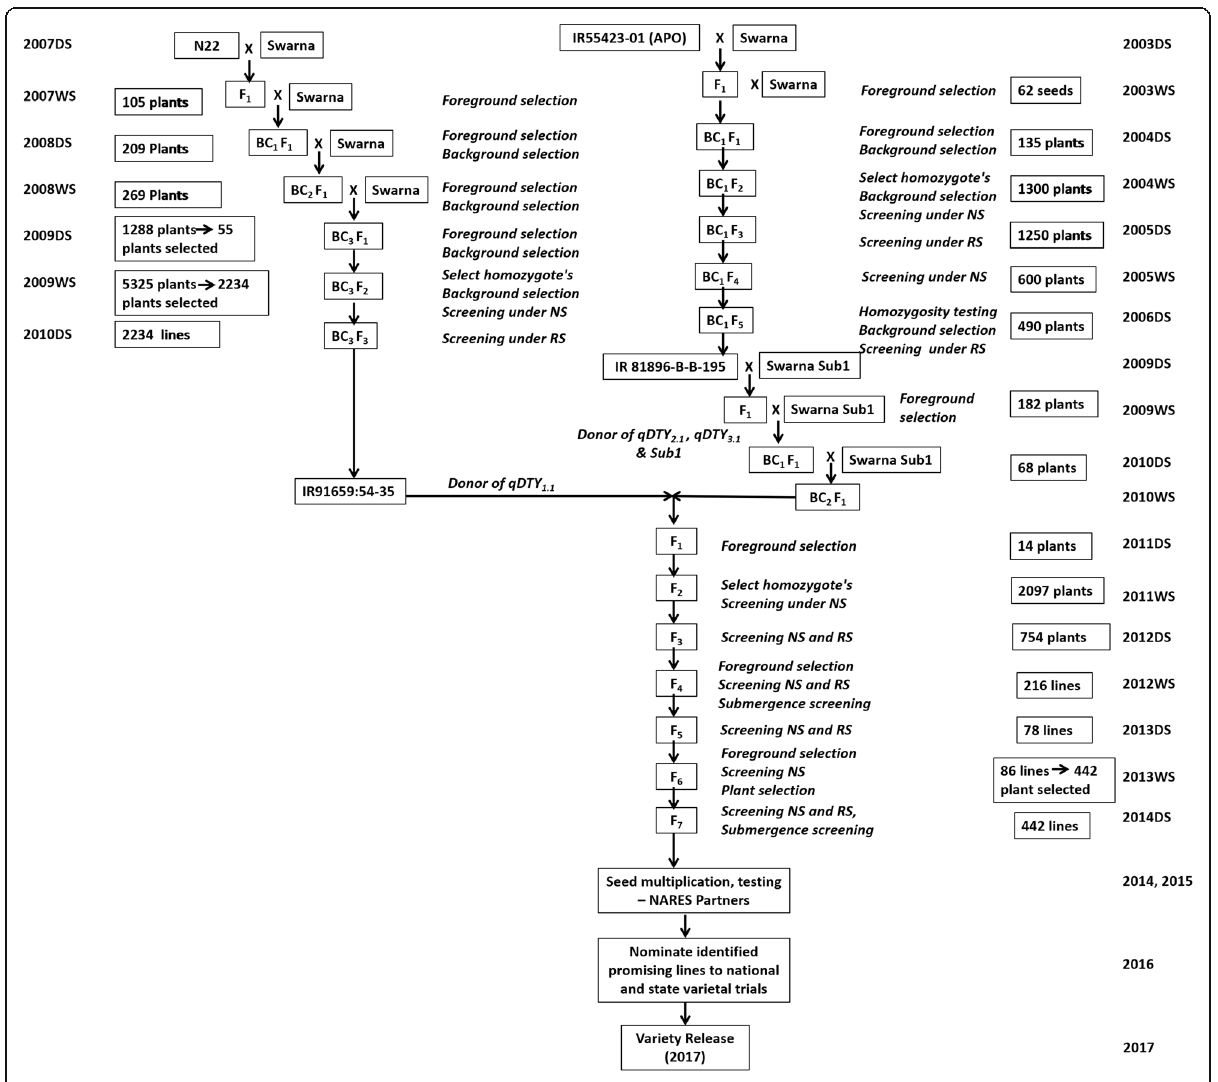
Fig. 5 Detailed scheme for the development of Swarna-Sub1 NILs. Details on the foreground, background selection and the number of plants selected in every generation using marker assisted backcrossing breeding approach. DS: dry season, WS: wet season, NS: non-stress, RS: reproductive stage drought stress, NARES: National Agricultural Research and Extension